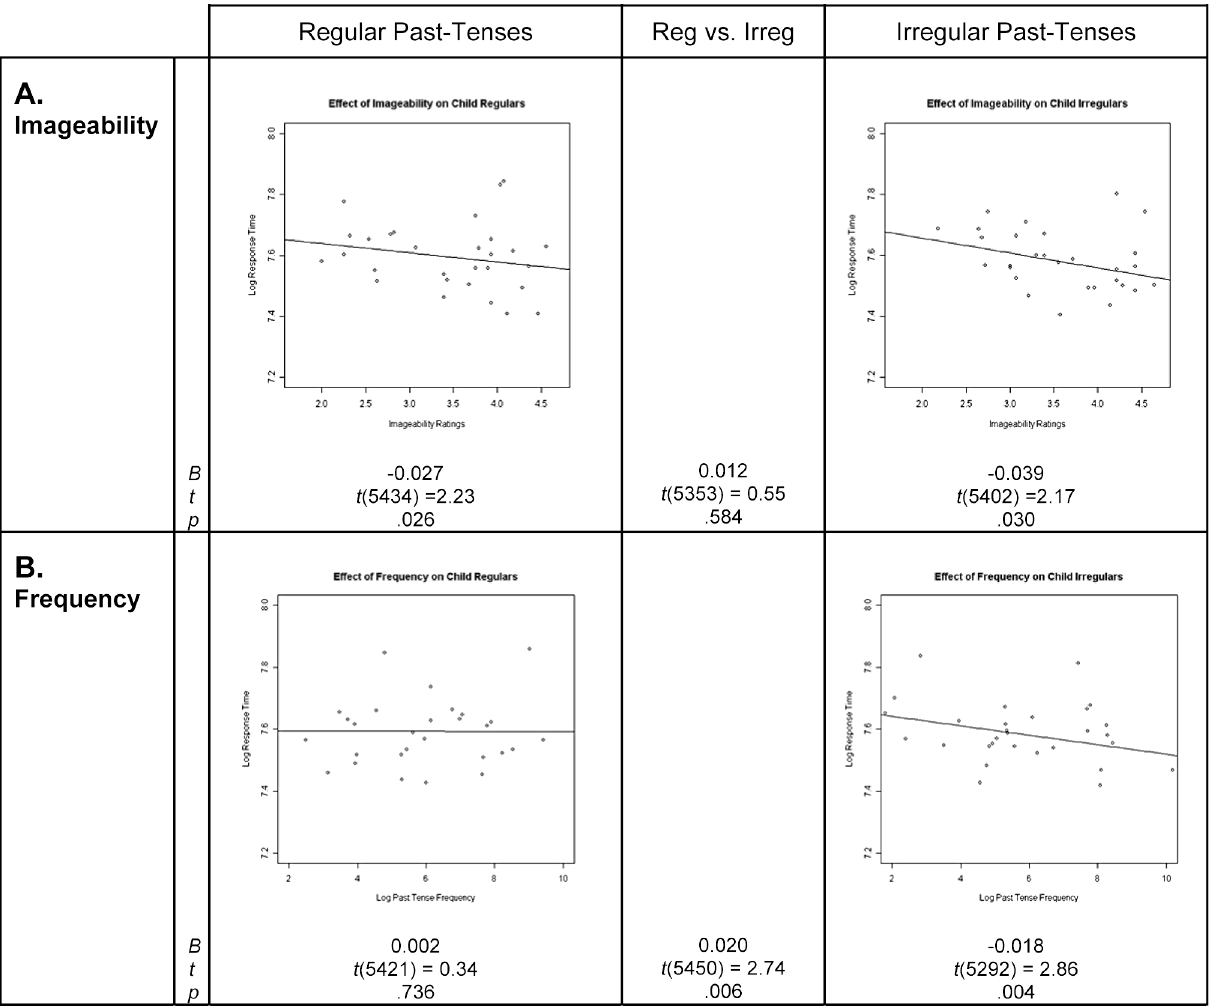
Figure 1. Children’s imageability and frequency effects for regular and irregular past-tense forms. In each scatterplot, the line represents the prediction of the mixed effects regression model with regard to the effect of imageability or frequency on the natural logarithm of response times, with the effect of all covariates removed. Points on the graph represent residuals from the model (with the effects of the covariates removed) for the 29 regular and 29 irregular verbs. B represents the unstandardized regression coefficient, indicating the slope of the regression line, t represents the t -statistic of the comparison between B and zero, and p represents the statistical significance of this comparison. Imageability effects in children versus adults. For